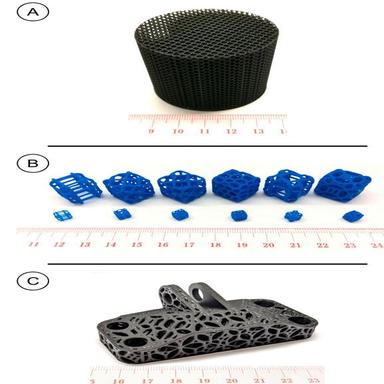
Photographs of printed parts, adjusted for visual clarity. (A) Larger scale lattice of the design in G, used in fluid applications . Approximate dimensions: 50 mm diameter x 50 mm height; lc = 2.4 mm; r \ = 0.11. (B) Lattice designs from A-F, from left to right. Approximate dimensions: 5.5 mm × 6 mm × 6.4 mm (small); lc = 3 mm; r \ = 0.07; large parts are scaled linearly by 3x. (C) GE engine bracket consisting of internal struts, boundary struts, wireframe edges (left, fro